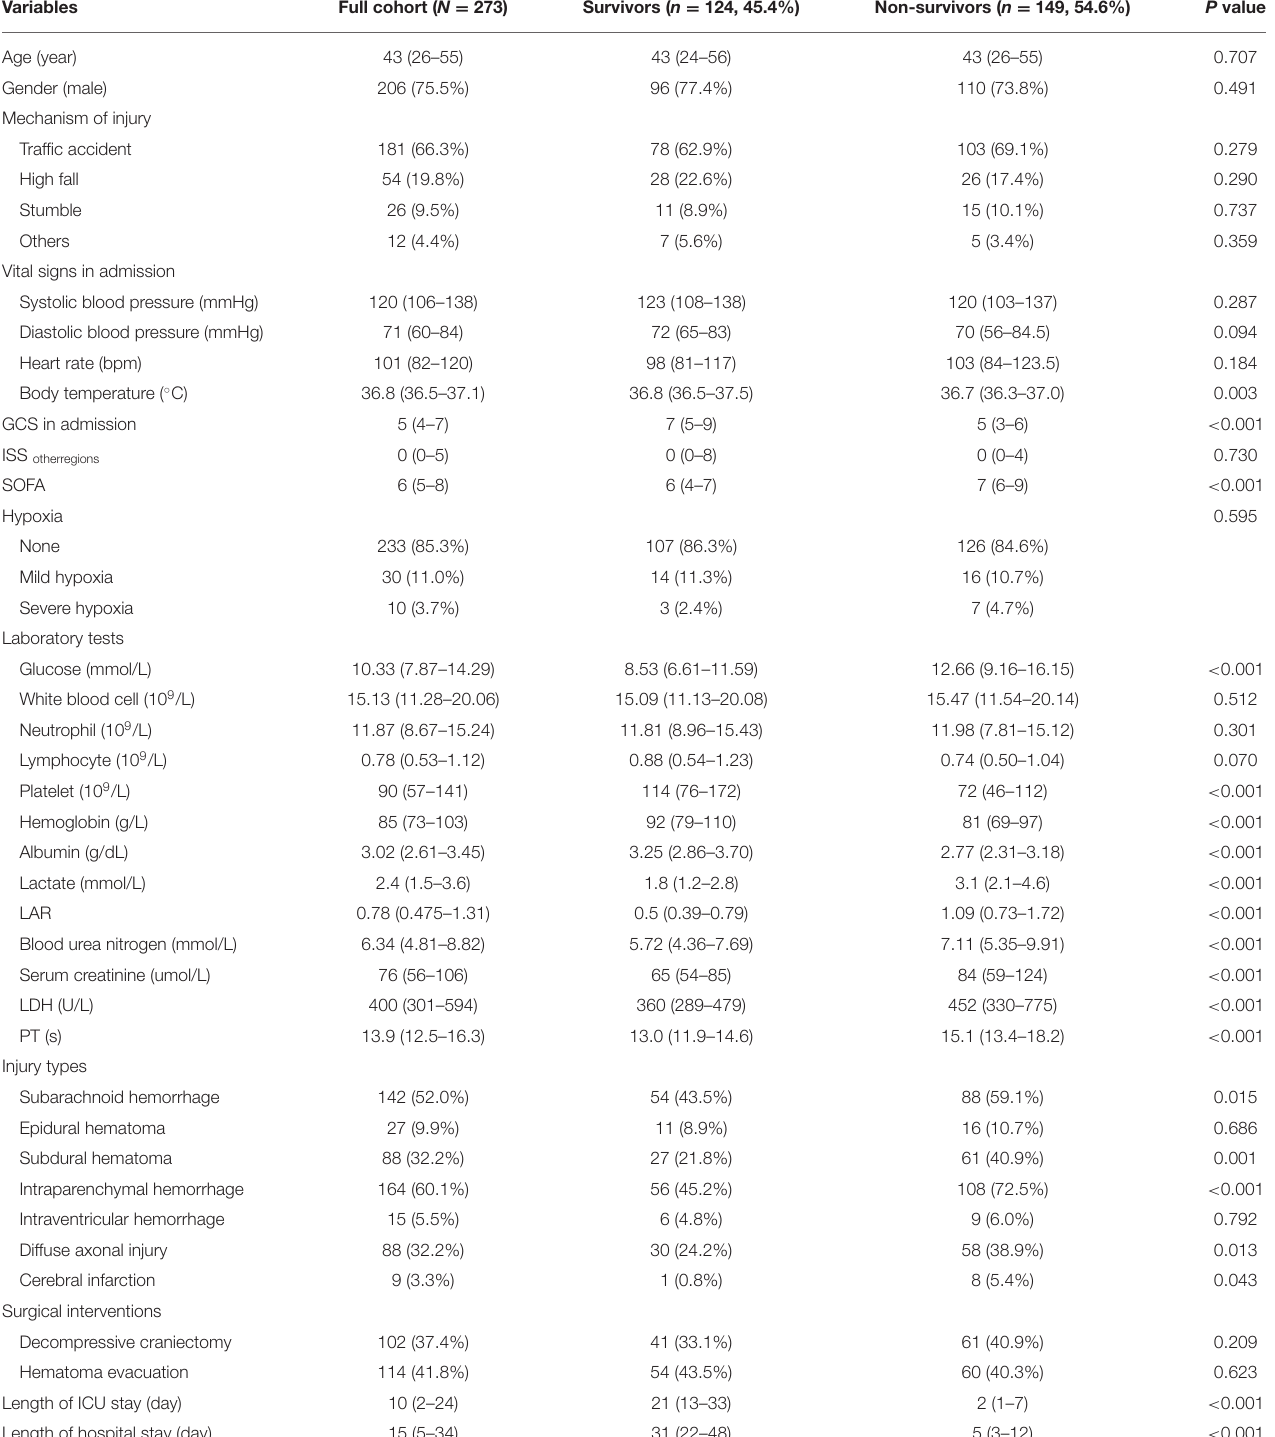
TABLE 1 | Baseline characteristics of included